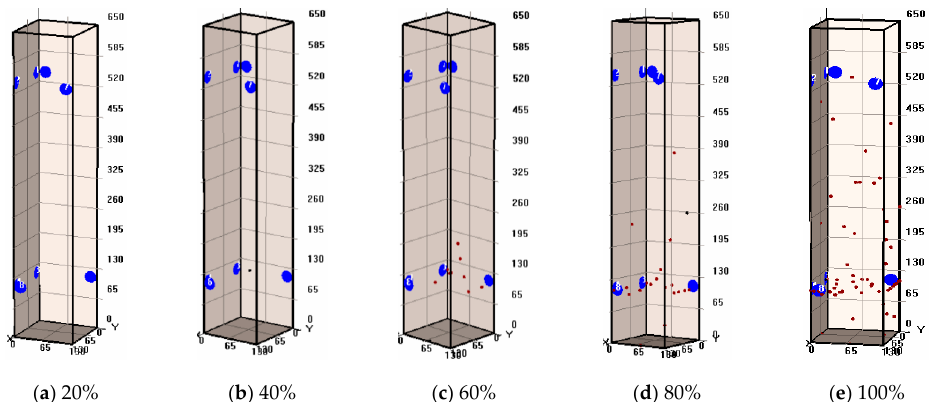
Figure 17. Testing results of AE events location at stages for non-corroded specimens with di ff erent load levels ( a ) 20%; ( b ) 40%; ( c ) 60%; ( d ) 80%; ( e ) 100% load levels.